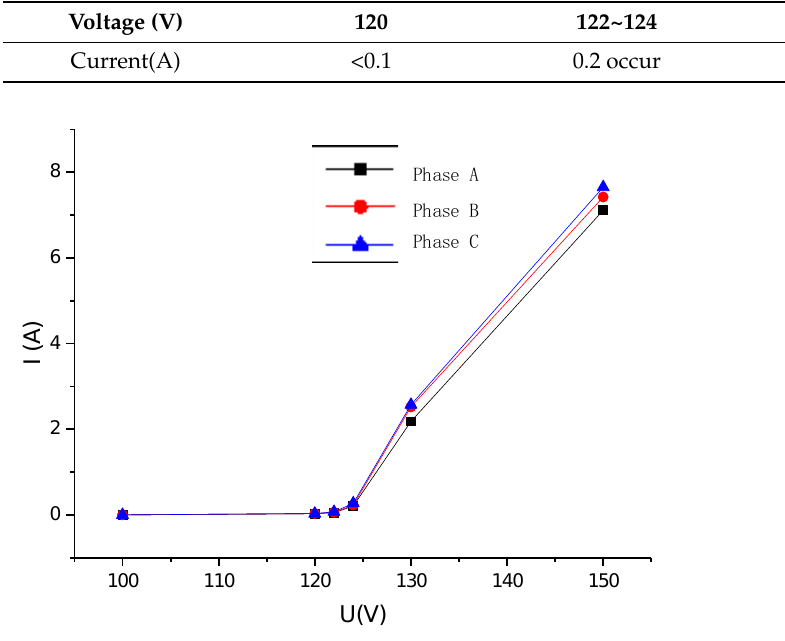
Figure 13. V-I characteristic curve of fast saturation damper. Table 5. The qualified standard for voltage–current characteristics of dampers.